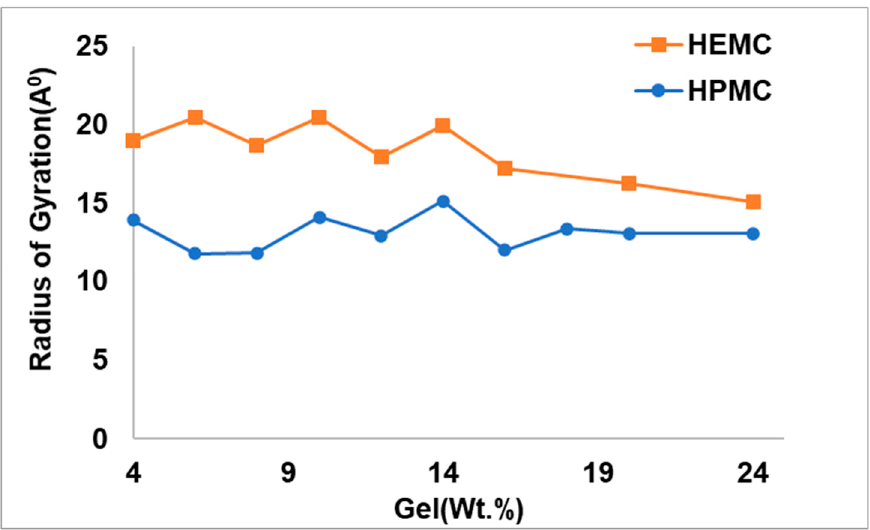
Figure 13. Radius of gyration of HEMC and HPMC at different polymer concentrations.